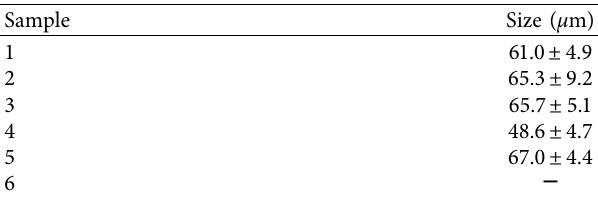
Table 2: Mean diameter ( μ m) of prepared microcapsules with different cross-linking